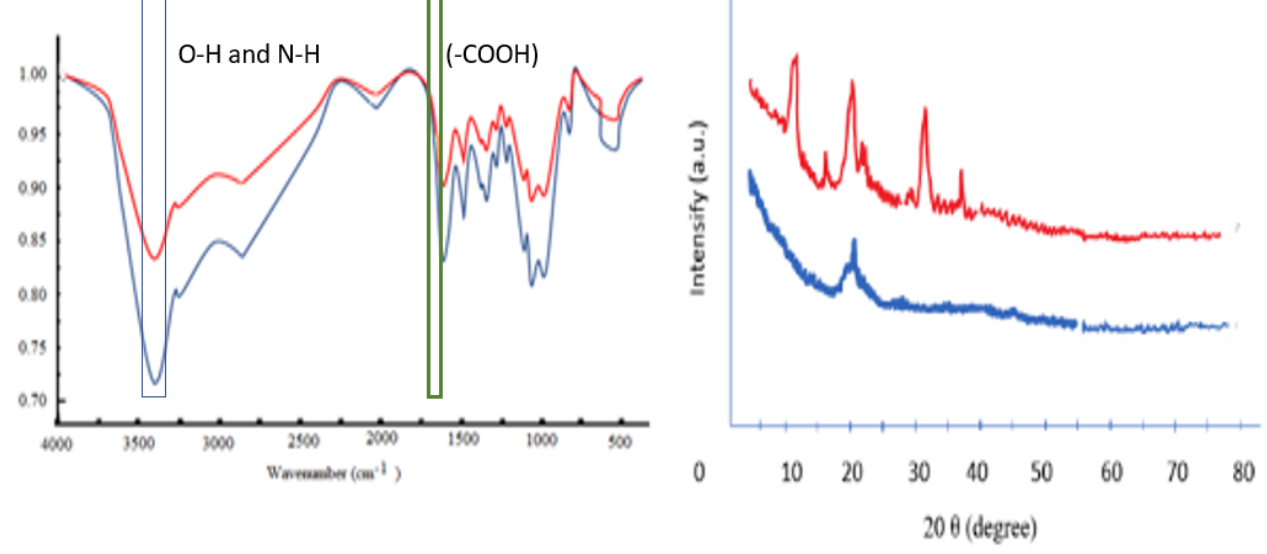
Figure 1. FTIR spectra and XRD spectra (1) CS – HMW (blue line); (2) CS – LMW (red line).